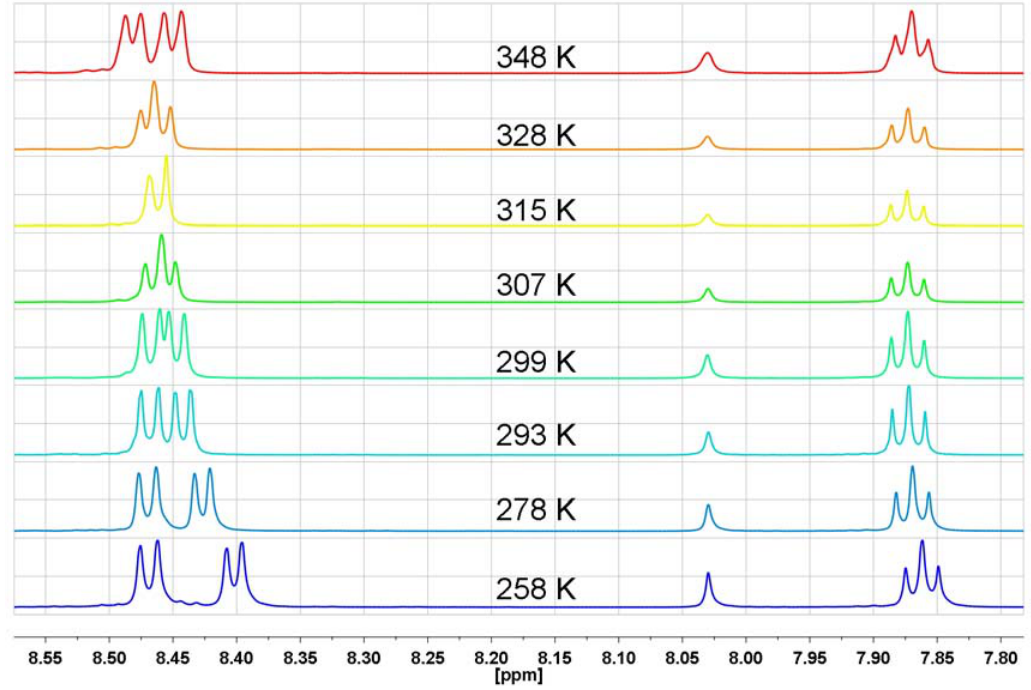
Figure 9. The range of aromatic protons of 1 H-NMR spectrum in DMF-d